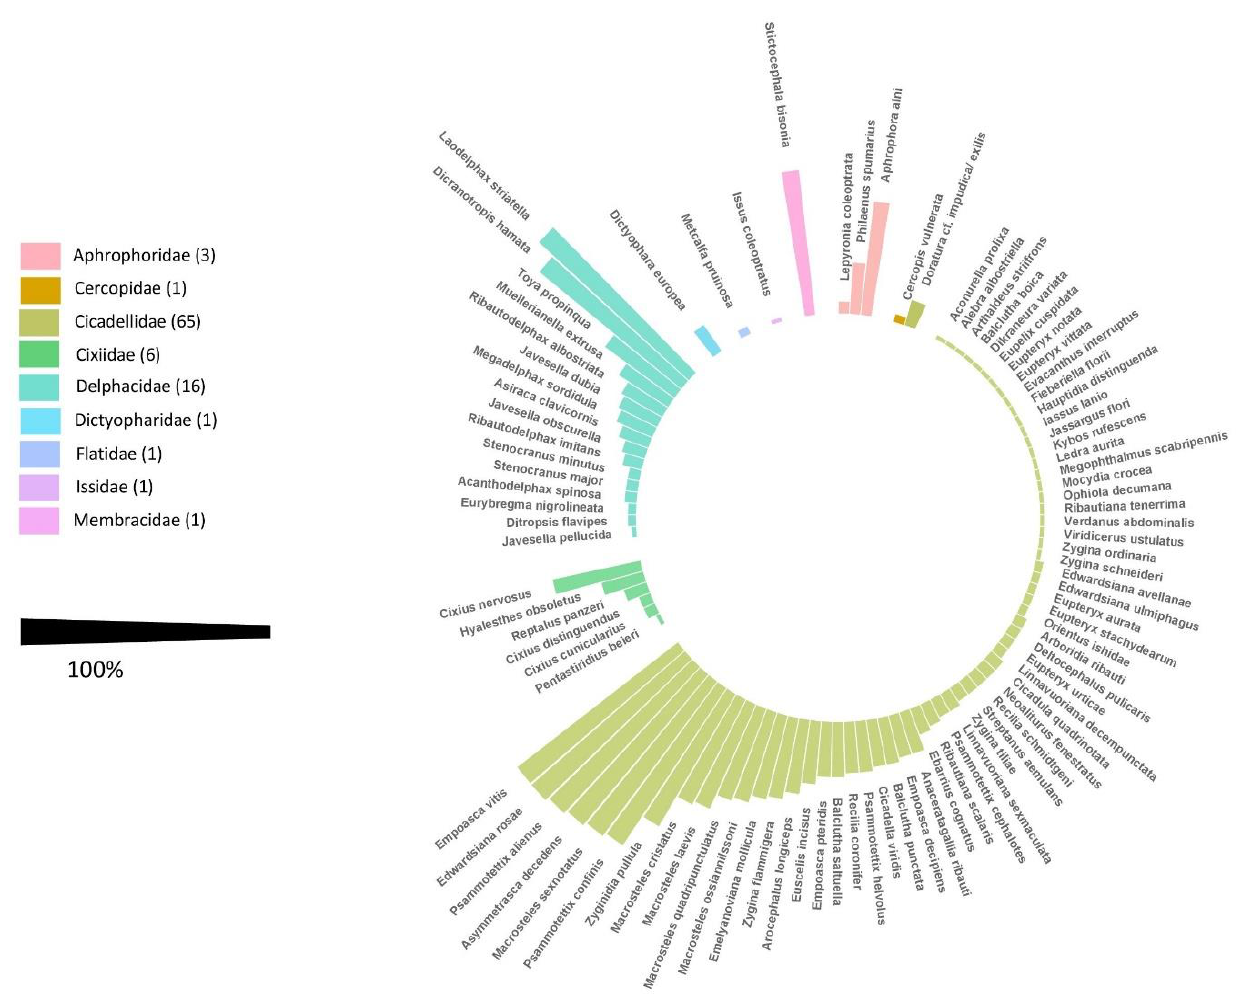
Figure 1. Overall frequency (F mean) of each Auchenorrhyncha species recorded during the whole study period in the agroecosystem “apple orchard”.